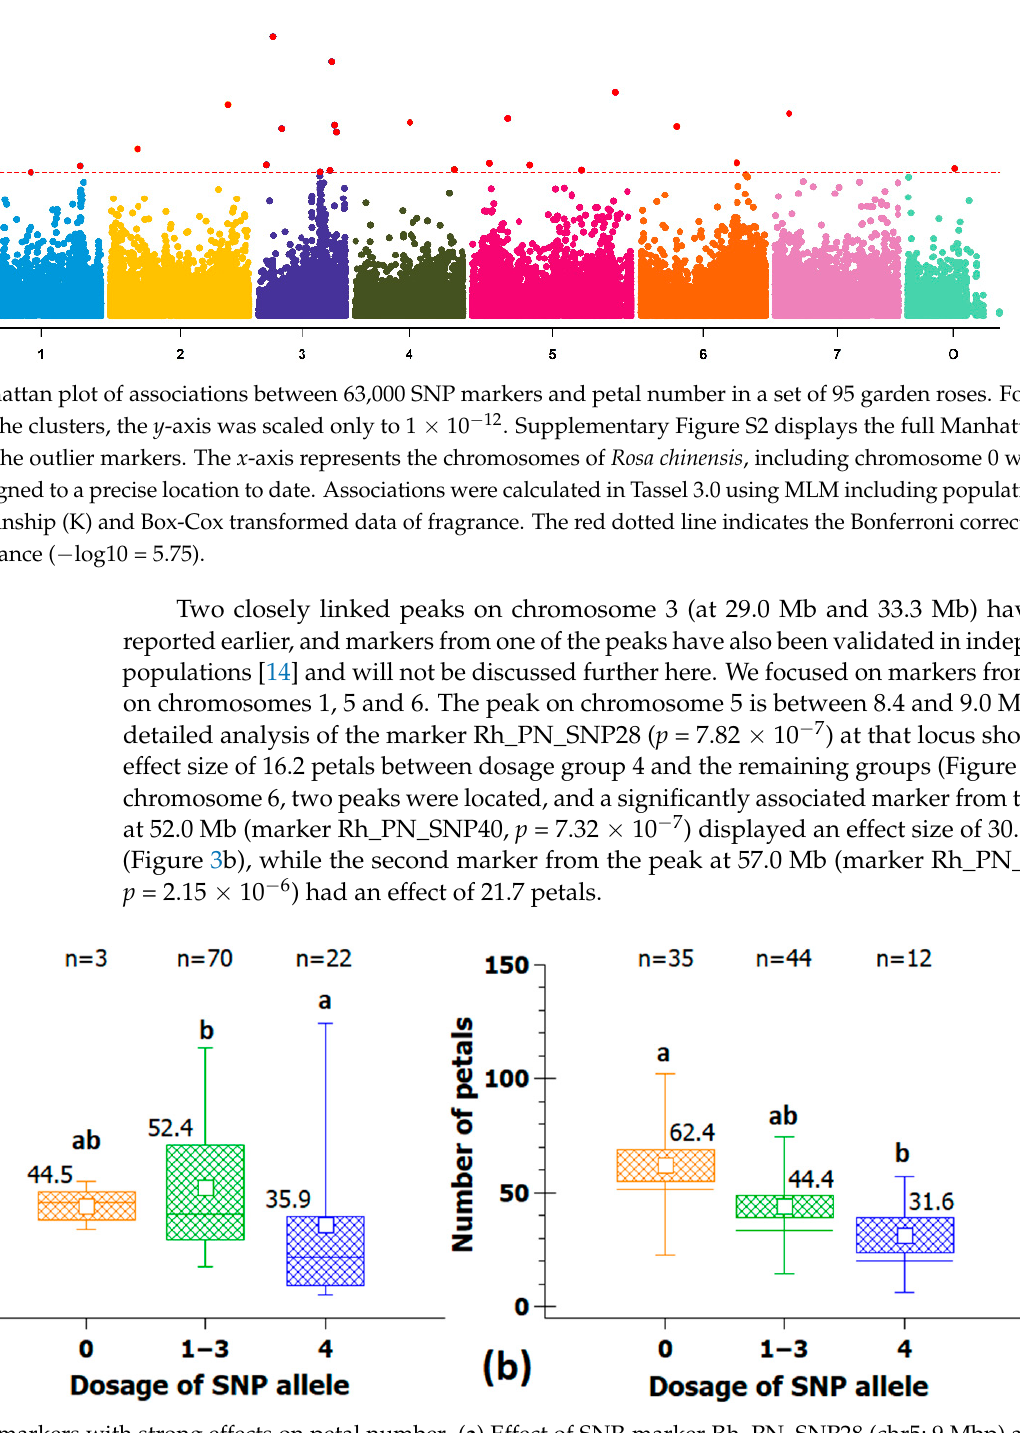
Figure 3. SNP-markers with strong effects on petal number. ( a ) Effect of SNP-marker Rh_PN_SNP28 (chr5; 9 Mbp) and ( b ) effect of SNP-marker Rh_PN_SNP40 (chr6; 52.0 Mbp) which could only be analyzed in 91 individuals. Numbers on the x -axis show the allelic dosage for the four marker classes (0 and 4 for the alternative homozygotes, and 1–3 for the heterozygotes, which were combined into one group for technical reasons). For each allele dosage group, the number of individuals (n) is given on top; groups that are significantly different at p ≤ 0.05 are indicated by letters above the whiskers (Kruskal-Wallis analysis of variance on ranks with all pairwise multiple comparisons (Dunn’s method); mean values are given above the box. The marker Rh_PN_SNP6 (P = 9.21 × 10 − 7 ) from the peak on chromosome 1 at 53.2 Mbp is linked to a locus with an effect size of 24 petals. This marker was converted into a